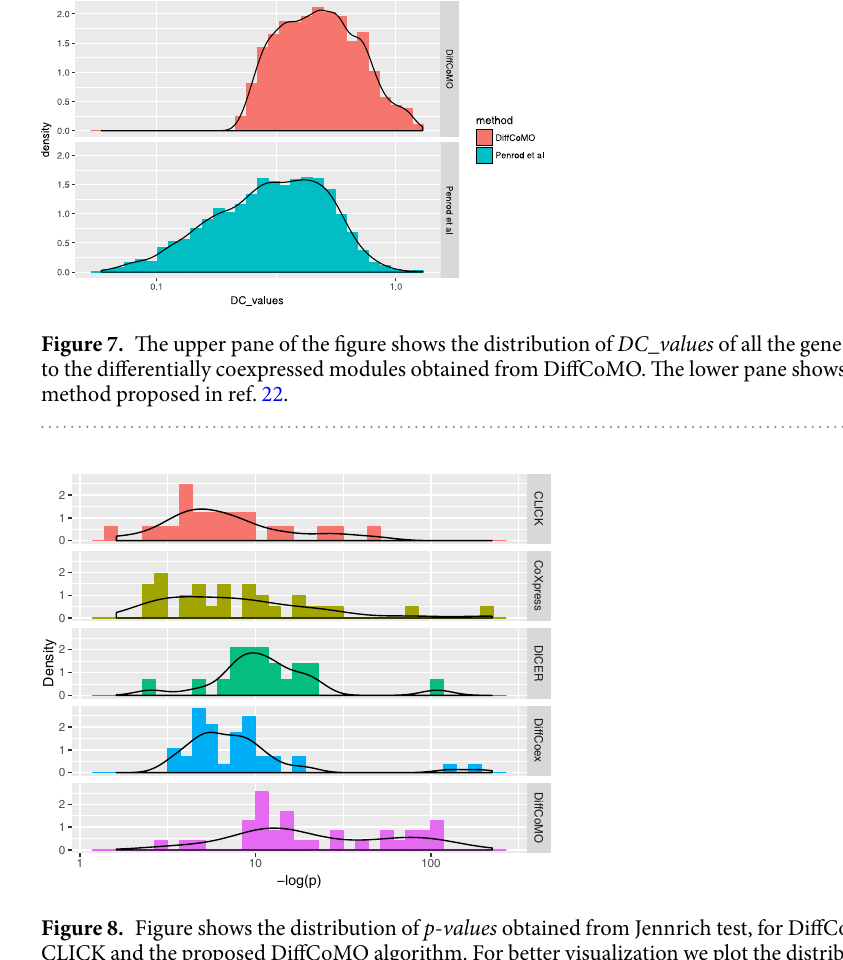
Figure 8. Figure shows the distribution of p - values obtained from Jennrich test, for DiffCoex, CoXpress, CLICK and the proposed DiffCoMO algorithm. For better visualization we plot the distribution of − log ( p ) values obtained from different